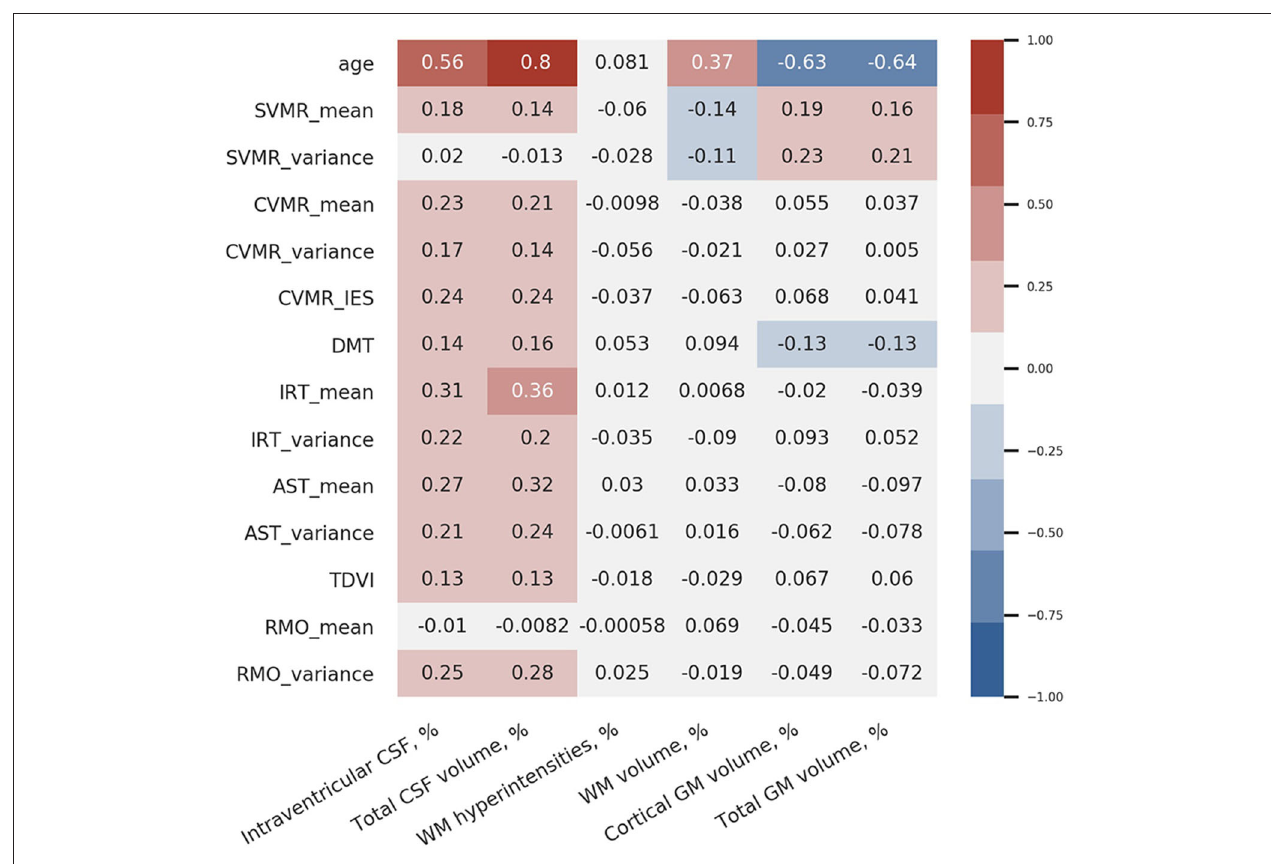
FIGURE 9 | Correlation coefficients between brain volumetric data and psychophysiological